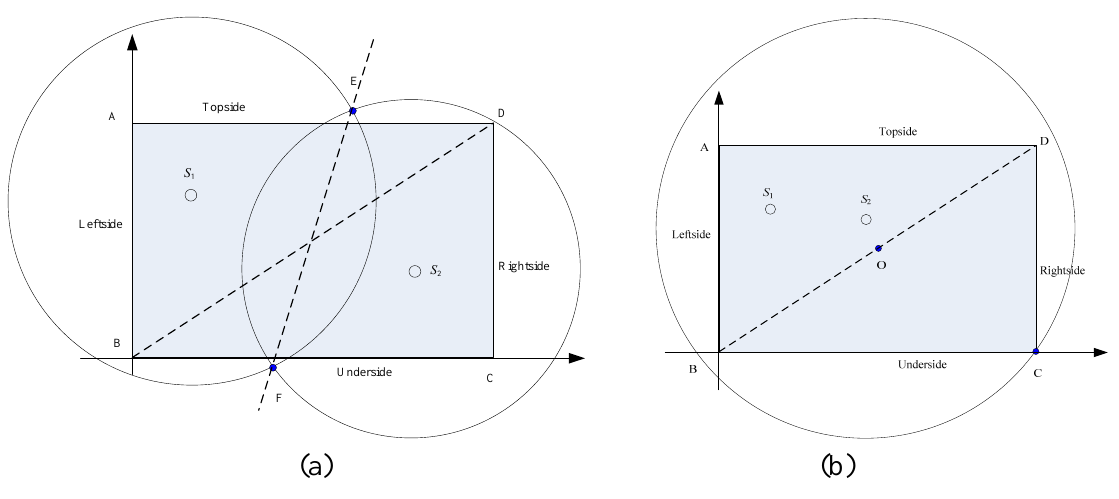
Figure 2. Illustration of WSNs with two sink nodes. (a) Two sinks at different sides; (b) Two sinks on the same